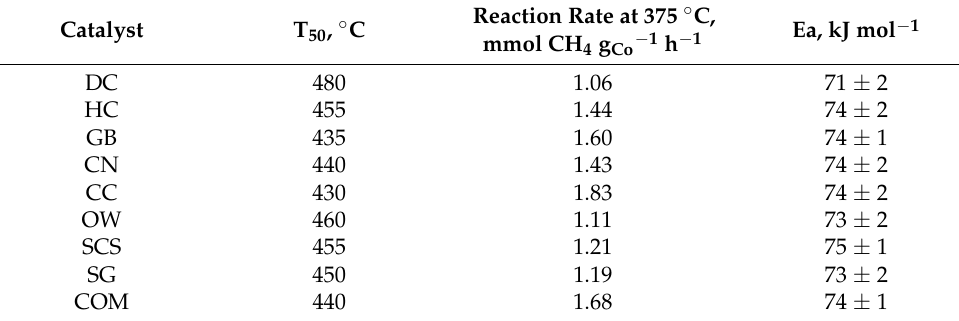
Table 4. Kinetic results of the bulk Co 3 O 4